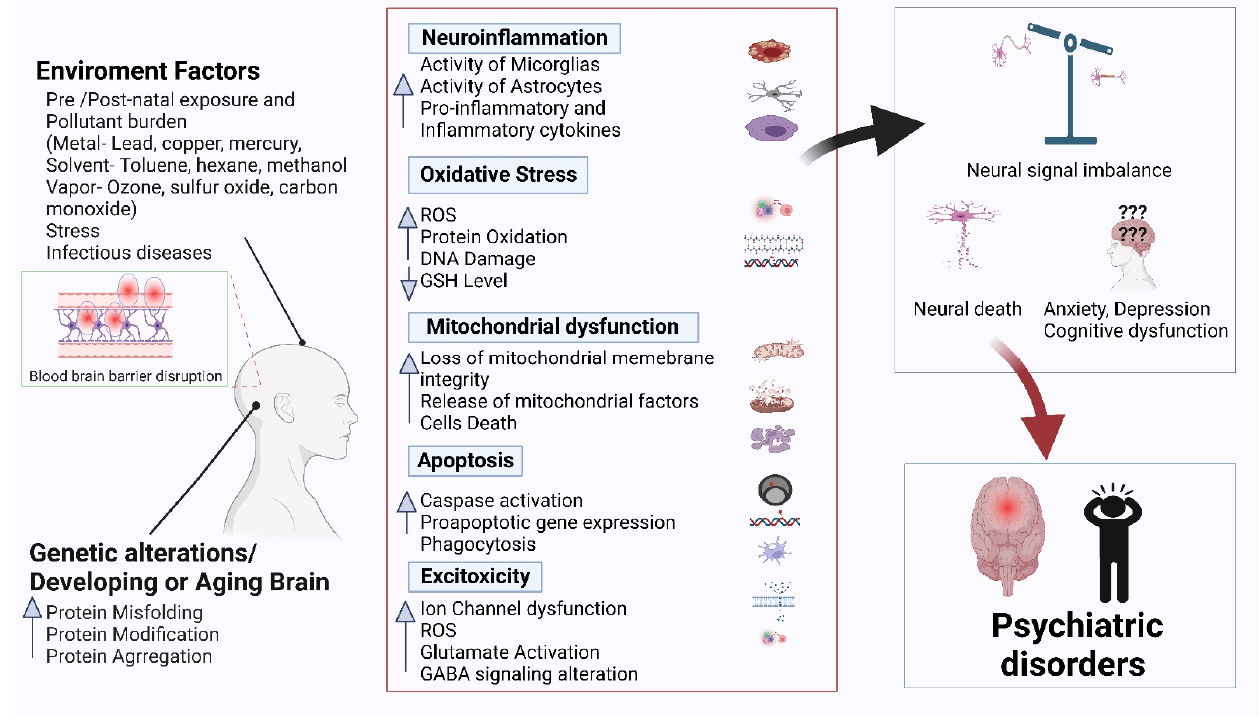
Figure 1. Common pathophysiology of psychiatric disorders.